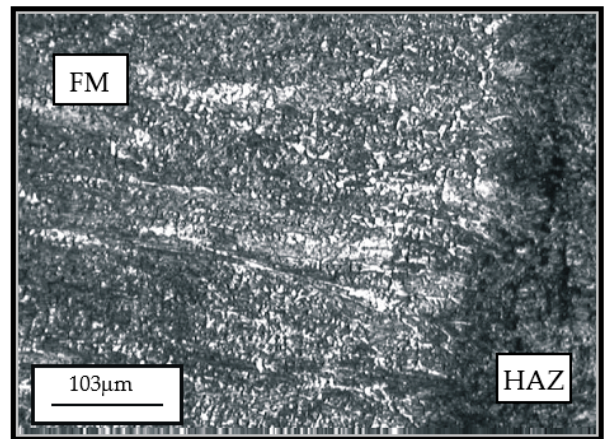
Figure 8. Appearance of microstructure of the hard-faced sample obtained by the UTP 670 (brighter areas) and the heat-affected zone of the base metal (darker areas).